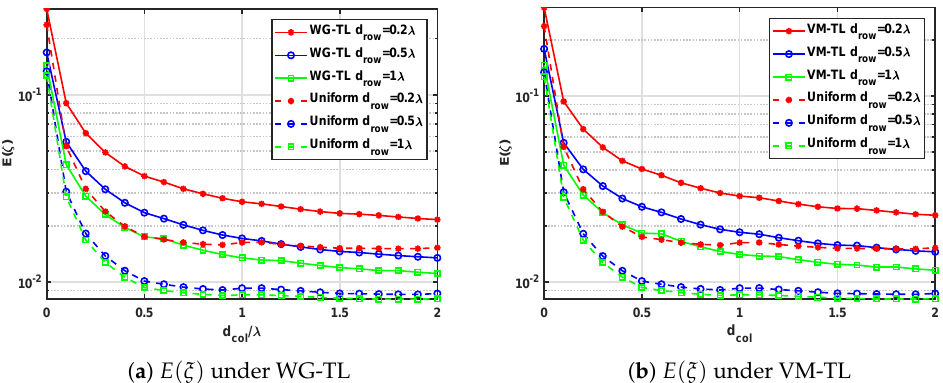
Figure 5. Expectations against the antenna spacing under WG-TL and VM-TL with the antenna number M = 128.